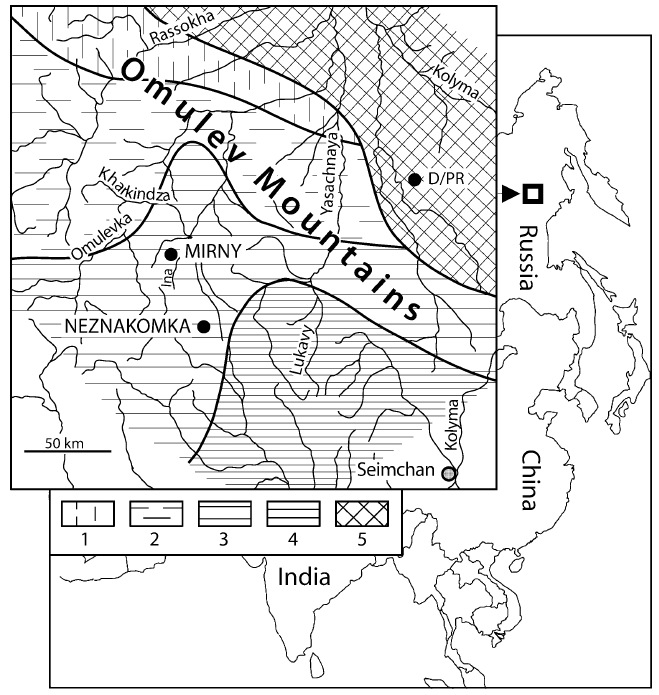
Fig. 1. Location of the two studied sections (black dots) in the Omulev Mountains area, NE Russia, on the background of late Ordovician facies zones according to Koren ′ et al. (1983). Key: 1, nearshore trachytes, breccias and limestones; 2, dolomitic limestones and marls formed in lagoons behind reefs; 3, upper slope belt of skeletal, silty and conglomeratic limestones with small bioherms (individually not shown); 4, lower slope belt with calcareous(cid:150)argillaceous shales and limestones; 5, land. D/Pr, Devonian rocks overlie